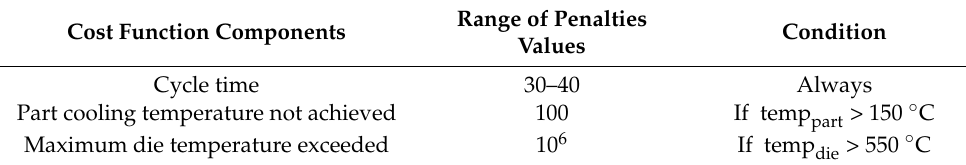
Table 4. Description of the MDP reward function.